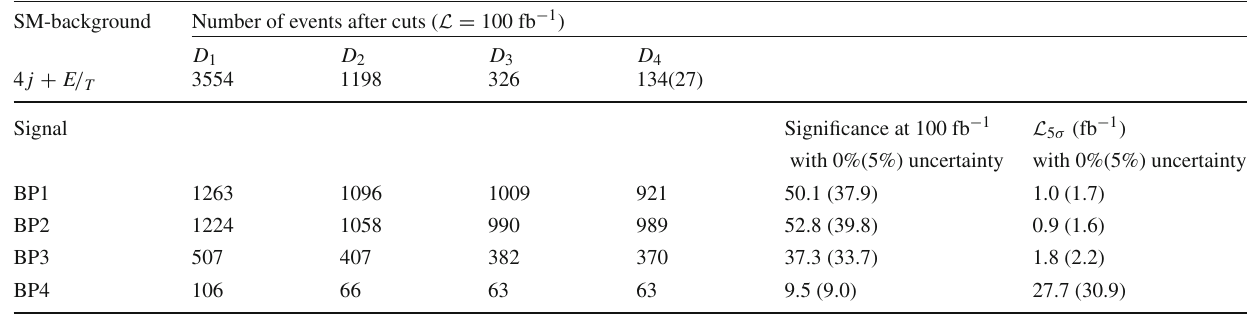
Fig. 6 Normalized distributions of η j Table 16 The cut-flow for signal and backgrounds for 4 j + E / T chan- nel along with the required integrated luminosity required for 5 σ sig- nificance for benchmarks BP1, BP2, BP3 and BP4 at 1 TeV ILC. The